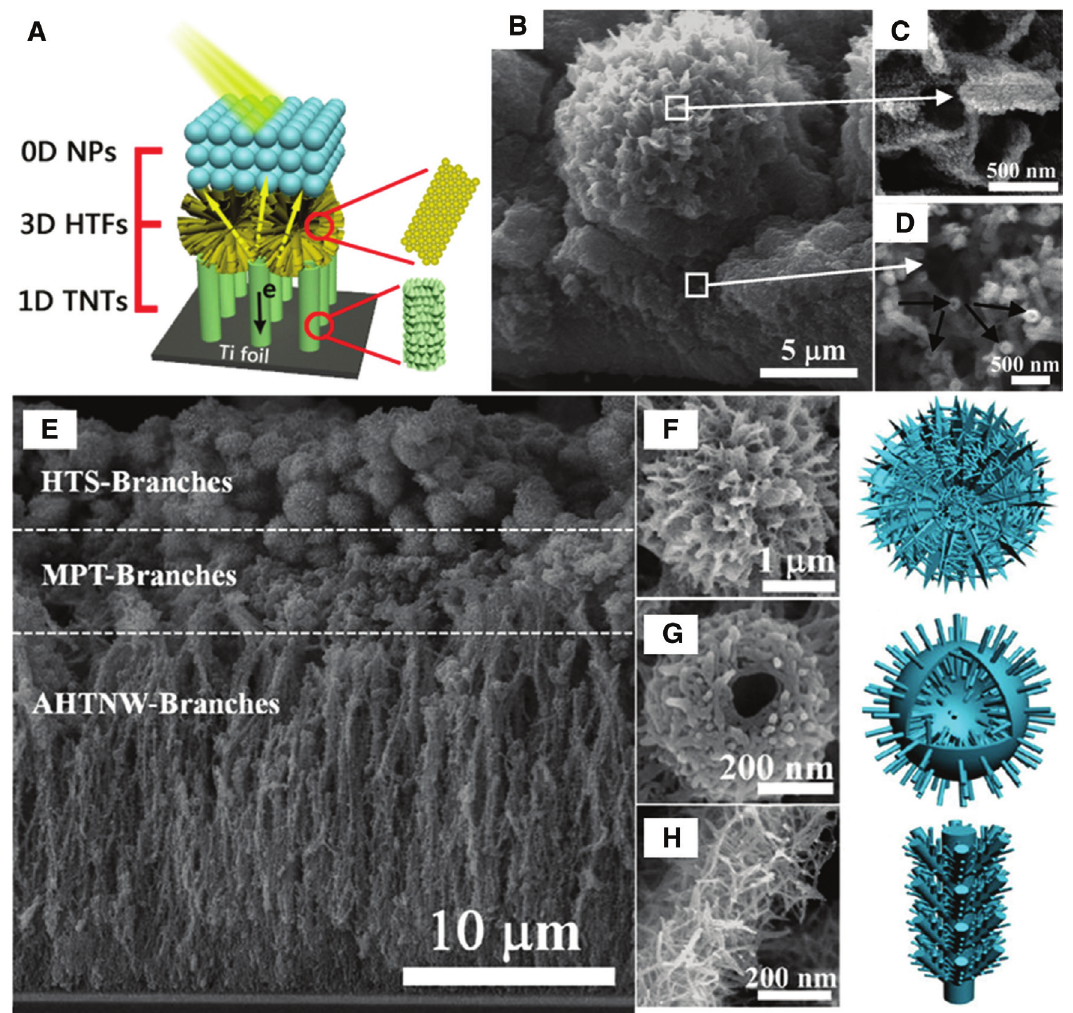
Figure 5 (A) The schematic diagram of the tri-layered photoanode on the Ti foil substrate. 0D NPs: conventional NPs; 3D HTFs: 3D hierar- chical TiO flowers; 1D TNTs: 1D TiO NTs. Incident light arrives at the NP layer first. (B–D) The 1D-3D double-layered structure (flower+NT) 2 2 formed by a two-step hydrothermal method. (E) The SEM cross-sectional images of the tri-layered hyperbranched TiO the FTO substrate. HTS-Branches: branched hierarchical TiO microspheres; MPT-Branches: branched macroporous TiO 2 AHTNW-Branches: branched anatase hierarchical TiO nanowires. The three layers form well-interconnected networks. (F–H) The enlarged 2 SEM images of the above three types of structures, showing the hyperbranched characteristics. The right column is the schematic drawing of the corresponding structures. (A–D) Reprinted with permission from Ref. [177]. (E–H) Reprinted with permission from Ref. [178]. Copyright (2014) American Chemical